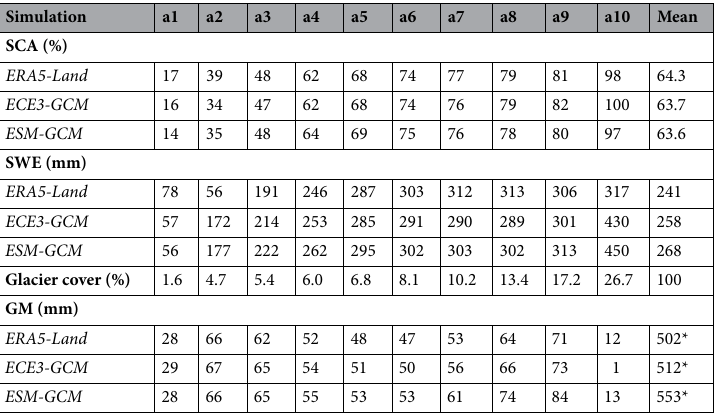
Table 1. Elevation-distributed annual average snow cover area (SCA), snow water equivalent (SWE), and glacier melt (GM) for ERA5-Land and GCM based inputs for the baseline period. *This glacier melt value is for the glacier area only, not for the whole basin.